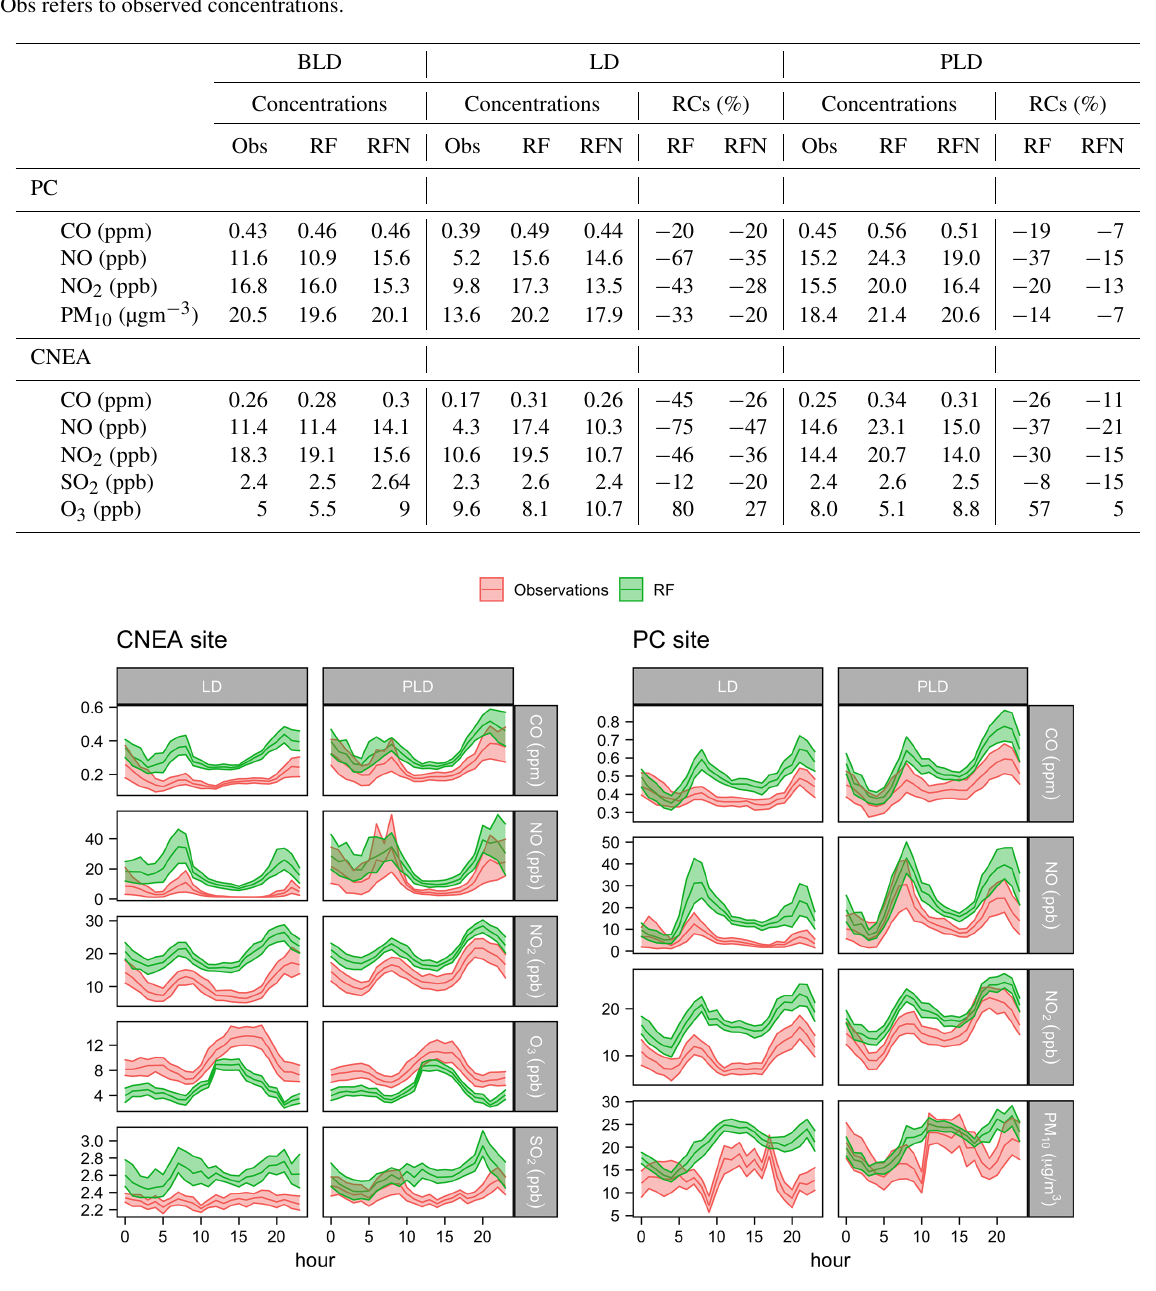
Figure 6. Mean diurnal cycle for the different pollutants for the LD (from 20 March to 13 April 2020) and the PLD (13 April to 25 May 2020) for both sites. The line represents the average diurnal cycle, and the shaded area represents the standard